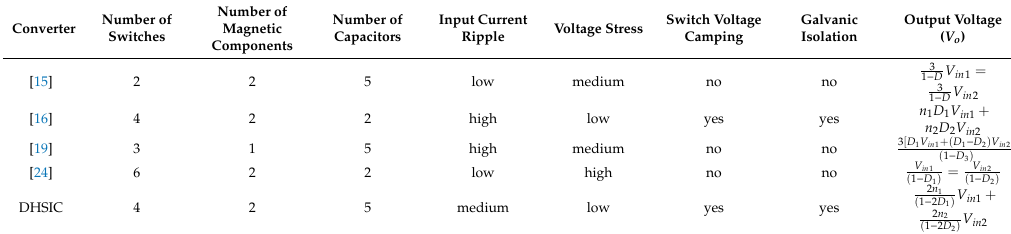
Table 1. Performance Comparison among the Proposed and Other Multi-Input Converters.